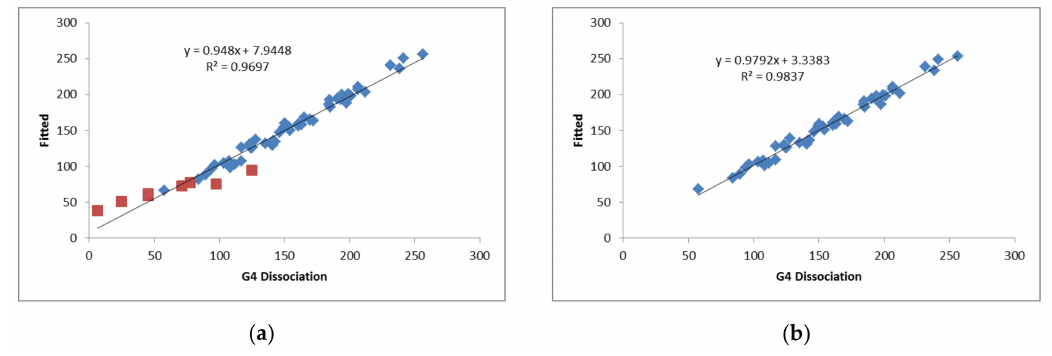
Figure 7. G4 Dissociation enthalpies vs. fitted values (kJ mol − 1 ). ( a ) Model 1: All the complexes with the Cl 2 Be indicated with red squares. ( b ) Model 2: All the complexes except those involving Cl 2